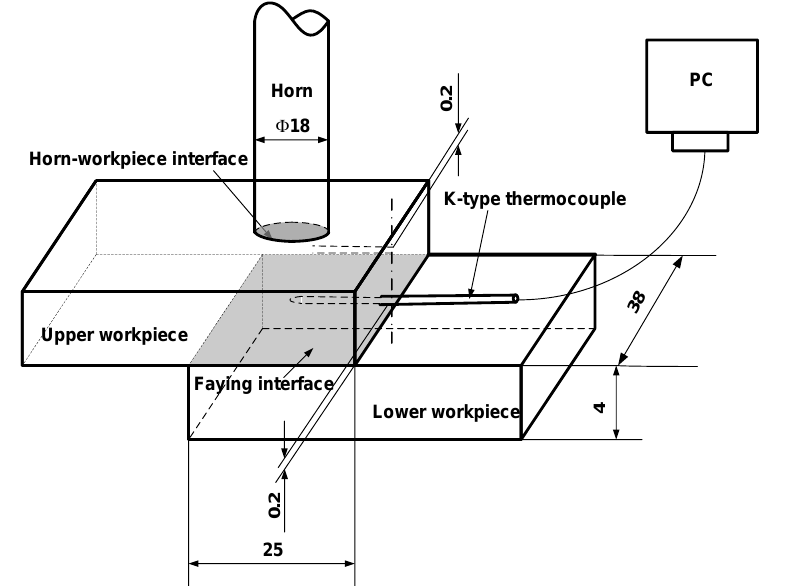
Figure 2. Sketch of the temperature measurement during the ultrasonic welding of injection molded 4 mm thick lapped C f /PA 6 composite without energy director (Dimensions in mm).